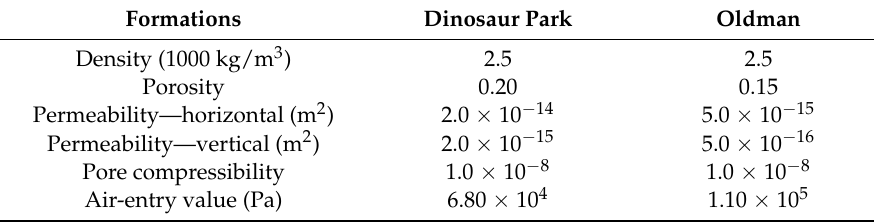
Table 3. Hydrogeological parameters for the modeling of CO 2 intrusion into the shallow aquifers.